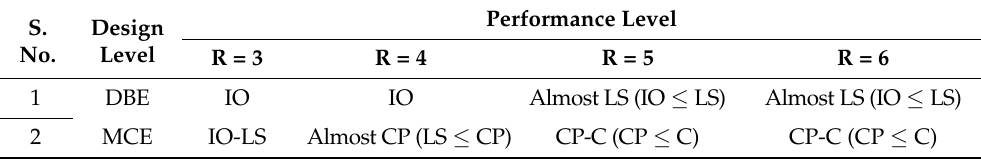
Table 8. Performance level at each building case under unidirectional loading.